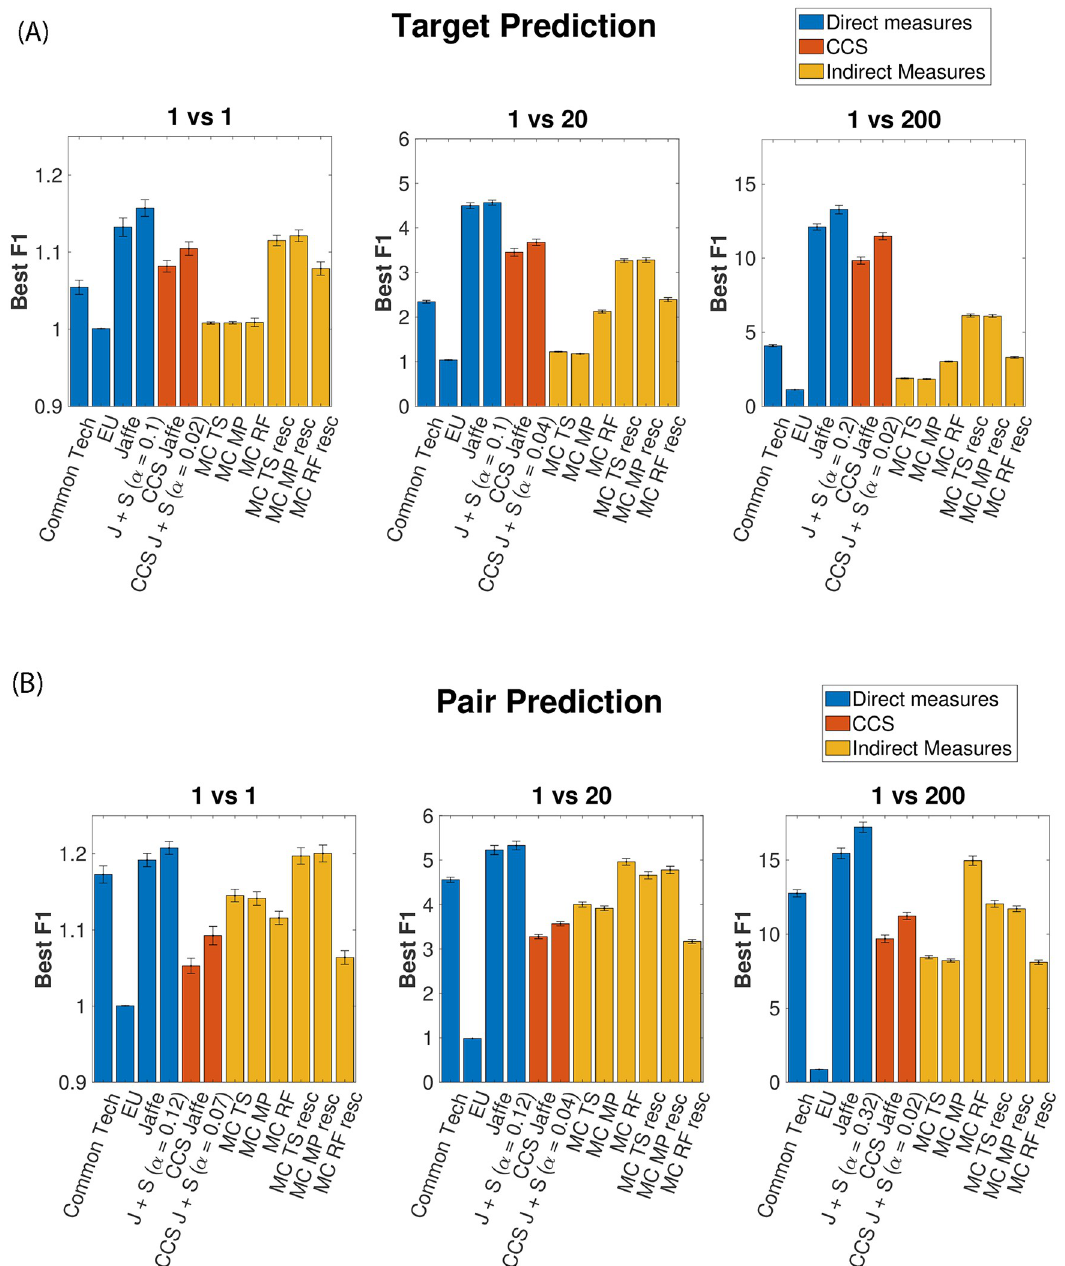
Fig 2. Predictions evaluation of Target and Pair forecasts. Comparison between the prediction performances of the different similarity metrics. We investigated different values of class imbalance, that is for each true M&A we extract 1, 20, and 200 negative cases (random couples with no deals). In both figures, we use three different colors to distinguish the typologies of metrics. Blue represents direct metrics, yellow indirect ones, and orange is the CCS ones. The error bars are computed by repeating the extraction of random Target companies and/or Acquirer companies 20 times. A : Comparison among the Best F1 scores on Target Prediction (fixed acquirer). B : Comparison among the Best F1 scores on Pair Prediction (both target and acquirer are not fixed). In both cases, Best-F1 values are normalised to ones of random predictions. With this normalisation, a Best-F1 value around 1 will indicate a random-like prediction, while values greater than 1 will correspond to more significant predictions. The Jaffe + Sectors metrics outperforms all other